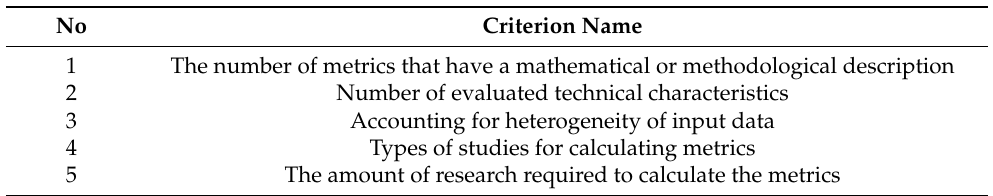
Table 2. Criteria for comparing